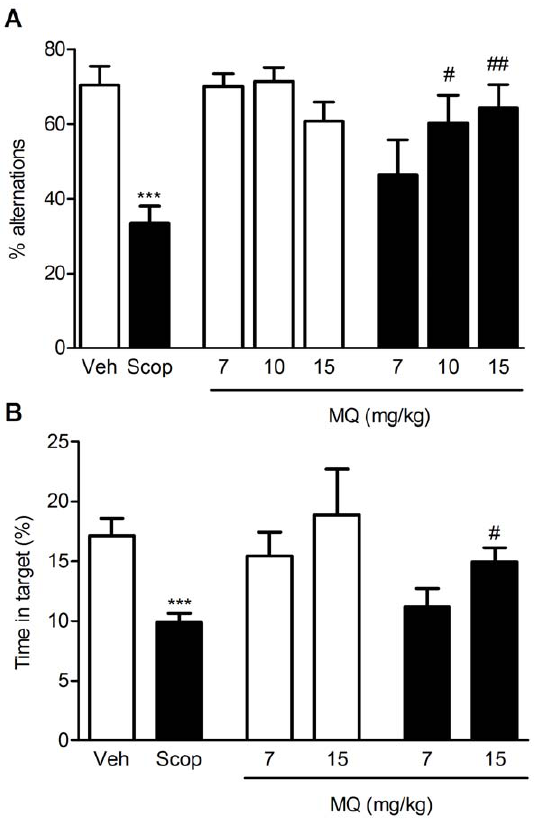
Figure 1. MQ rescues scopolamine-induced spatial memory deficits. Effect of MQ treatment on spontaneous alternation behavior (A) and MWM (B) in a scopolamine-induced amnesia model in mice. In the T-maze, MQ (7–15 mg/kg , p.o.) was administered 20 min